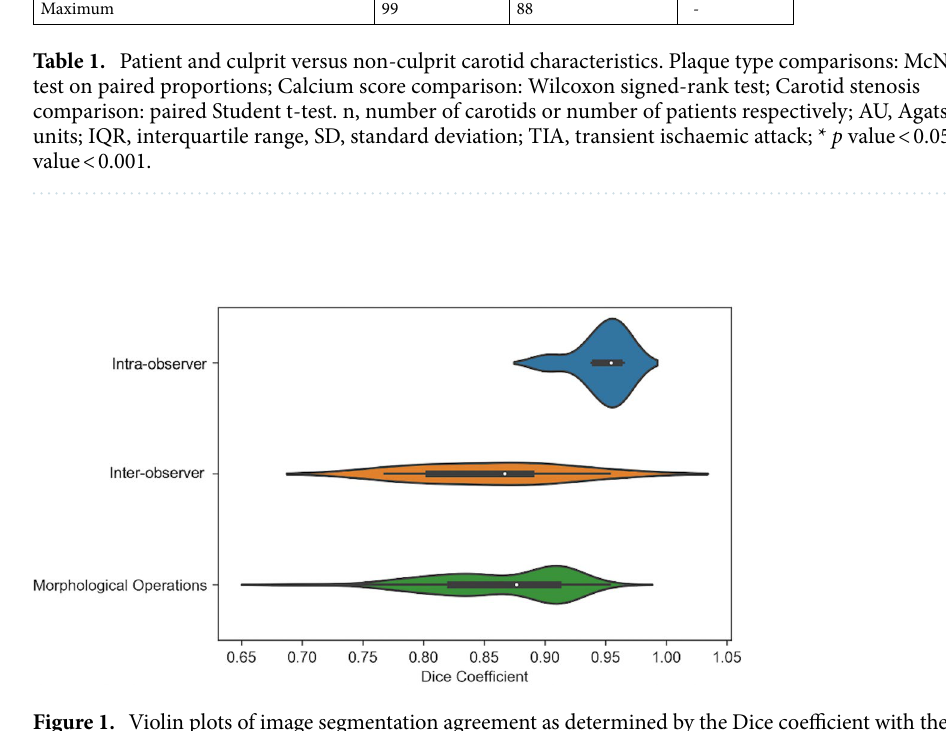
Figure 1. Violin plots of image segmentation agreement as determined by the Dice coefficient with the original ROI. Intra-observer variability was determined by manual segmentation of the ROIs by the same observer (EPVL) at two separate time points for 8 carotid arteries. Inter-observer variability was determined by manual ROI segmentation by two independent observers (EPVL and CW), performed on 8 carotid arteries. The ROIs drawn by the primary observer (EPVL) on 82 carotid arteries were compared with those generated following dilation and erosion morphological operations in single-slice analysis to determine the Dice coefficient distribution of systematic ROI perturbations. The violin plots each contain a black box-plot of the Dice coefficients, with the white dot representing the median Dice coefficient. Whereas the box-plots correspond to the actual data points of the Dice coefficients, the coloured shapes provide a visualisation of the underlying Dice coefficient distributions via kernel density